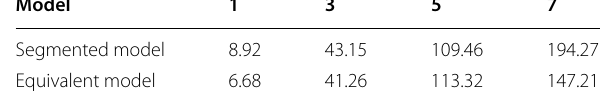
Table 1 Frequency of each step of TTM (Hz) Model